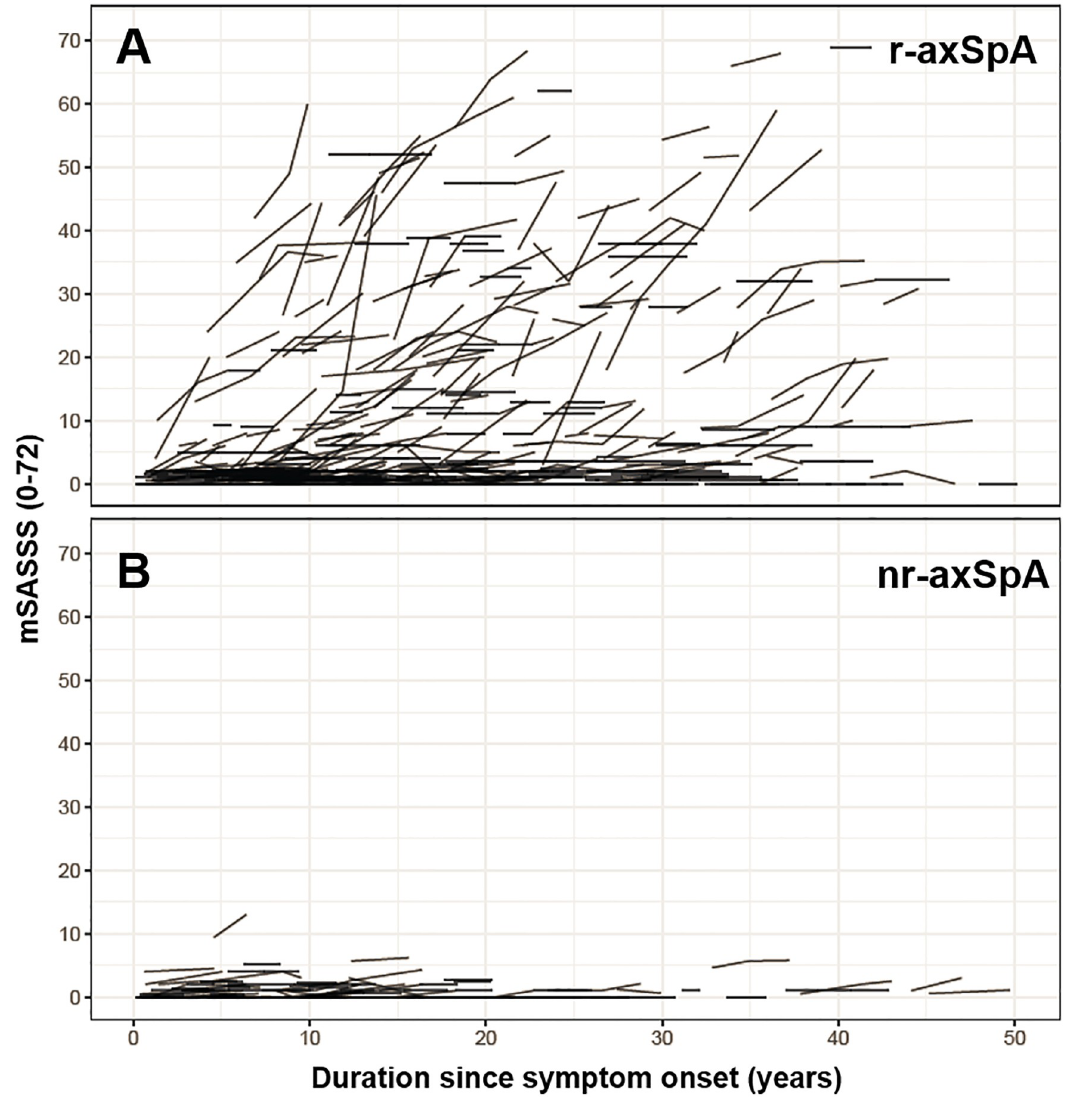
Fig 2. Modified Stoke Ankylosing Spondylitis Spine Score (mSASSS) for individual patients plotted as a function of duration since symptom onset. A. Patients with r-axSpA. B. Patients with nr-axSpA.